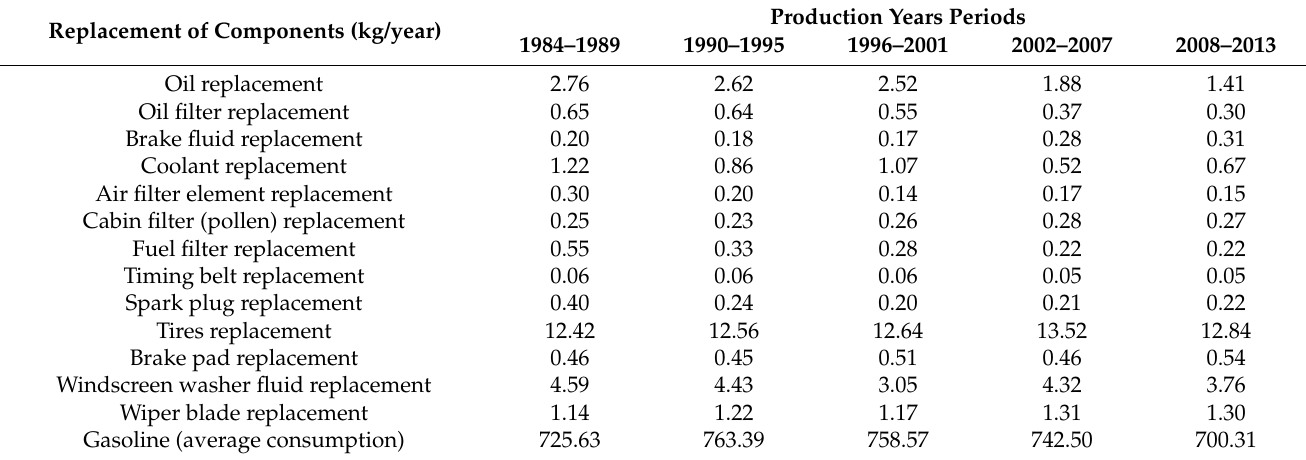
Table 5. Average material input for elements to be replaced per